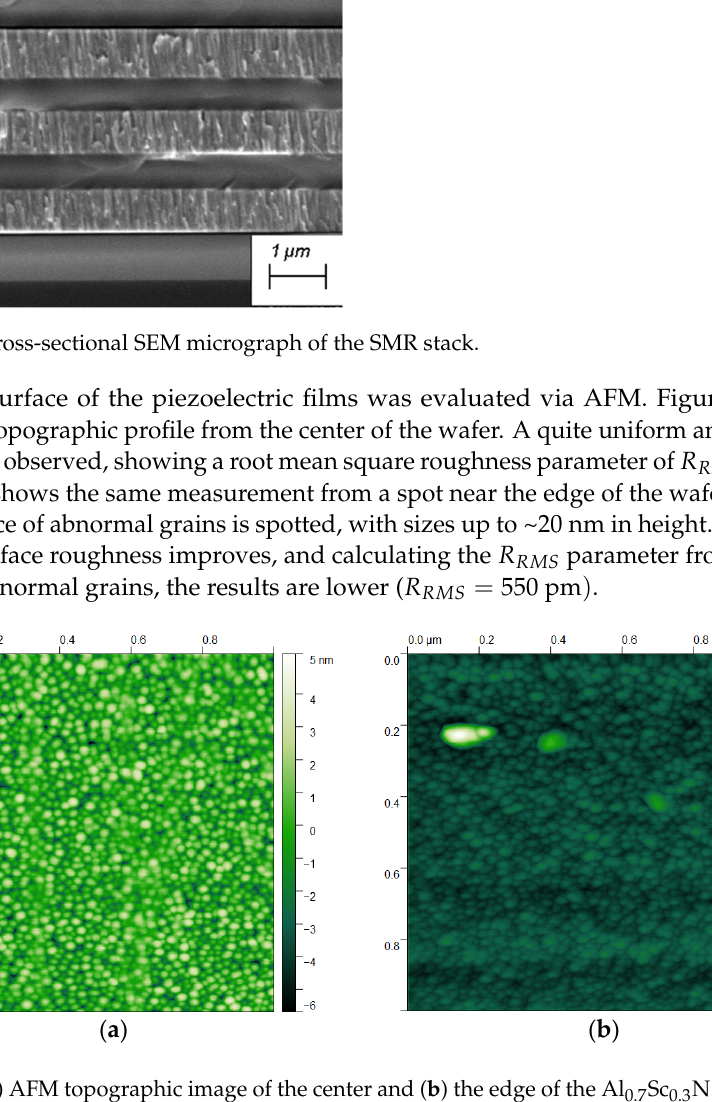
Figure 6. ( a ) AFM topographic image of the center and ( b ) the edge of the Al 0.7 Sc 0.3 N films deposited on 8 ‐ inch Si wafers.